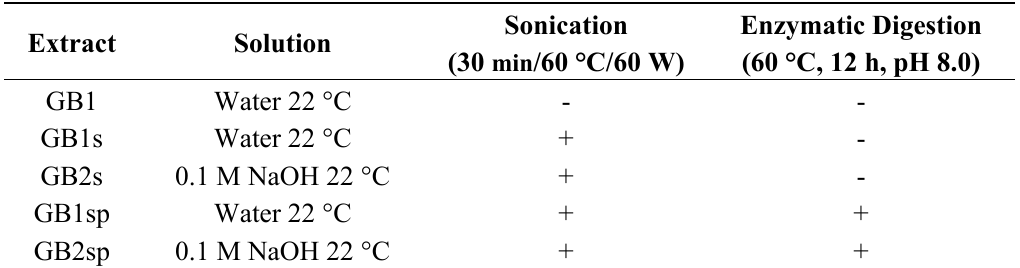
Table 4. Conditions to extract sulfated polysaccharides from Gracilaria birdiae